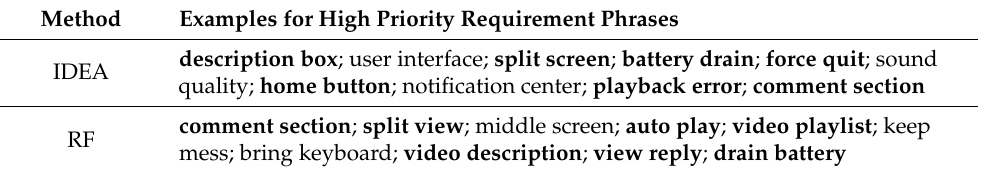
Table 8. Qualitatively comparison with IDEA (the phrases styled in bold font represent the correctly identified high priority